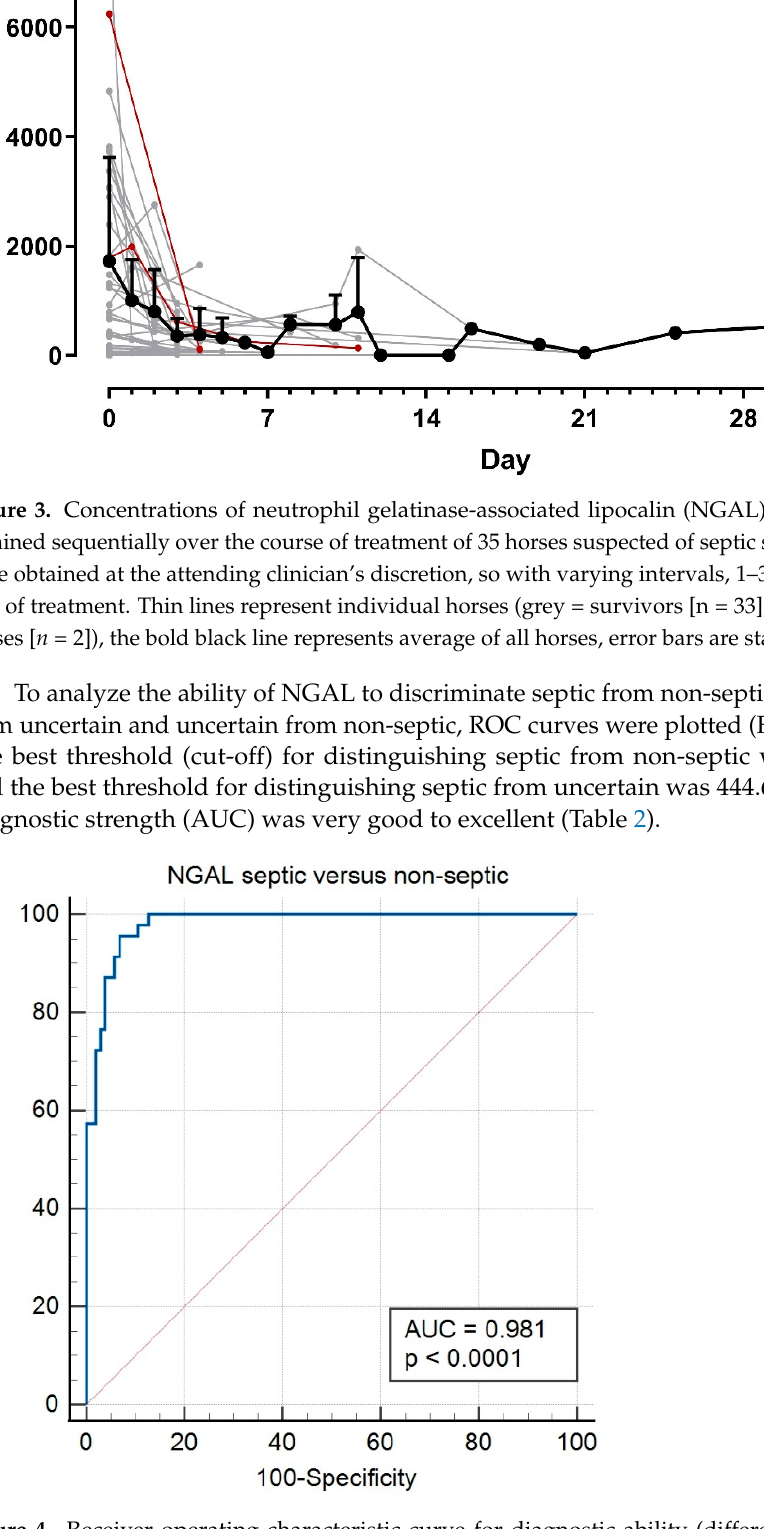
Figure 4. Receiver operating characteristic curve for diagnostic ability (differentiation of septic and non-septic) of neutrophil gelatinase-associated lipocalin (NGAL) in synovial fluid from horses. AUC = area under the